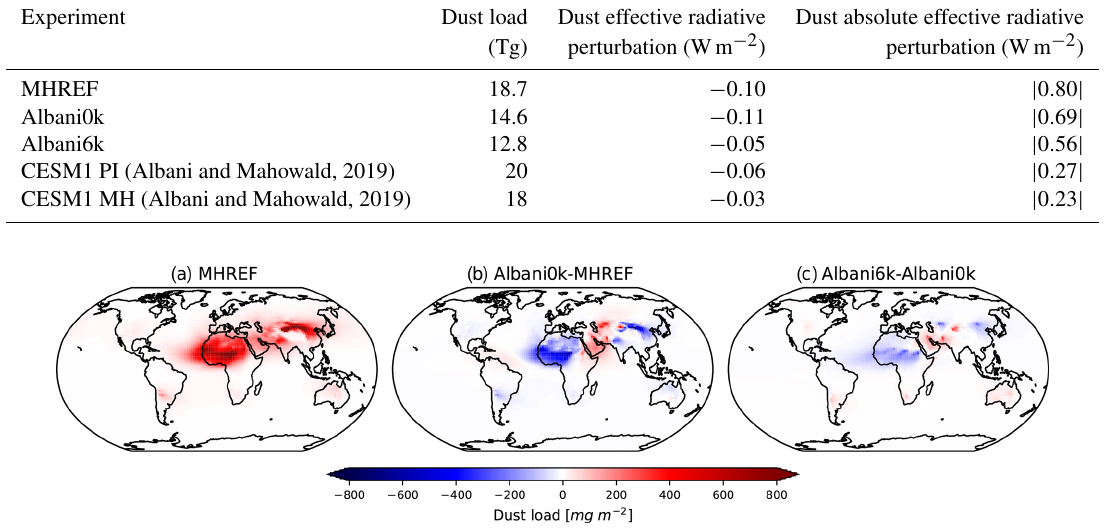
Figure 3. Comparison of the annual mean dust loads (mgm − 2 ) from the different simulations. (a) Reference version with the present day IPSL dust load as used in the reference mid-Holocene simulation, MHREF. (b) Differences between Albani’s and the IPSL PI dust load and (c) differences between Albani’s MH and PI dust